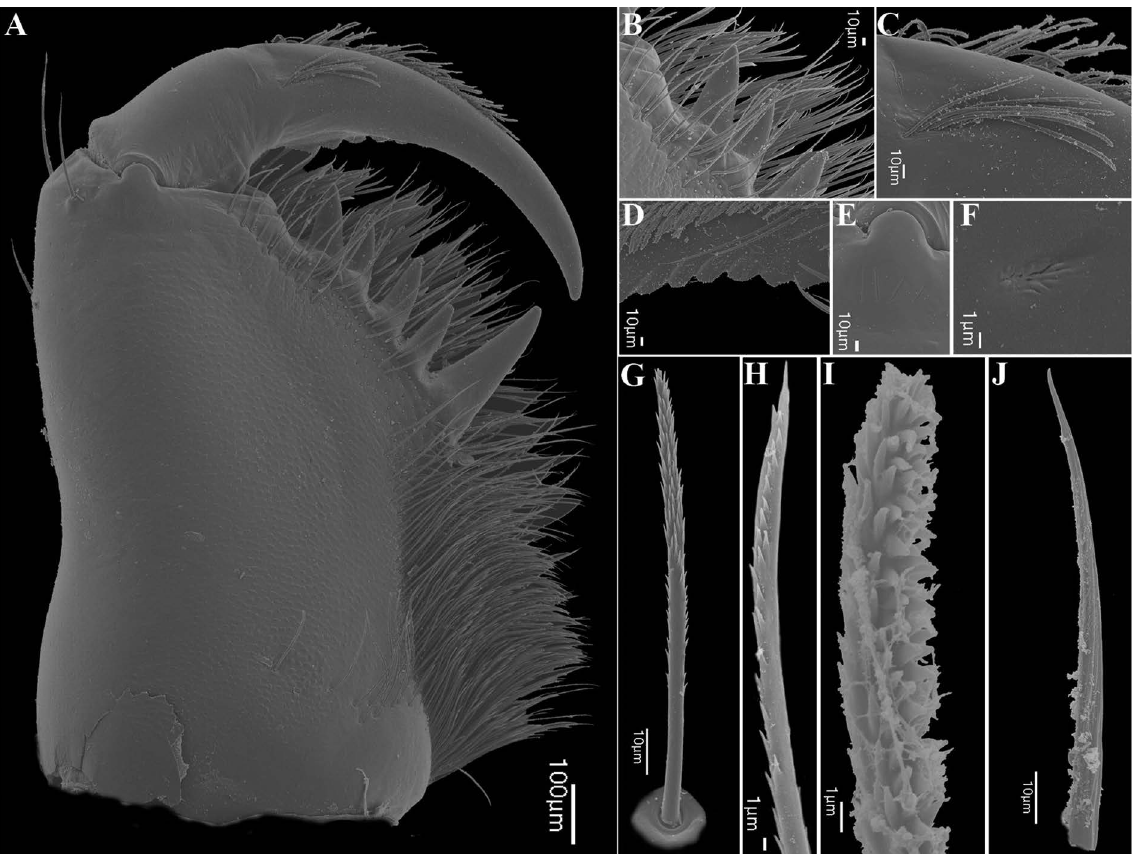
Fig. 84. Charinus africanus Hansen, 1921 (AMCC [LP 6943]), chelicera, ♀. A . Prolateral view. B . Retrolateral projection, opposite to bifid tooth. C . Setal row on cheliceral claw. D . Cheliceral claw teeth. E . Position of gland on joint between basal segment and cheliceral claw. F . Gland. G . Seta on cheliceral basal segment. H . Apex of basal segment seta. I . Seta on cheliceral claw. J . Setae on dorsal surface of cheliceral basal